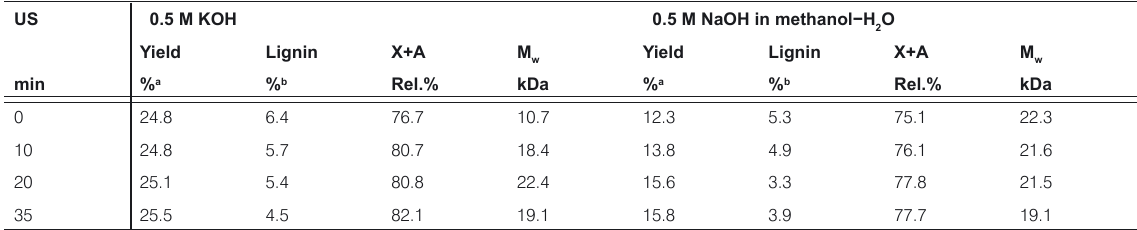
Table 5. Yield, composition and molecular properties of hemicelluloses isolated from wheat straw by alkaline and alkali/methanol extractions with and without